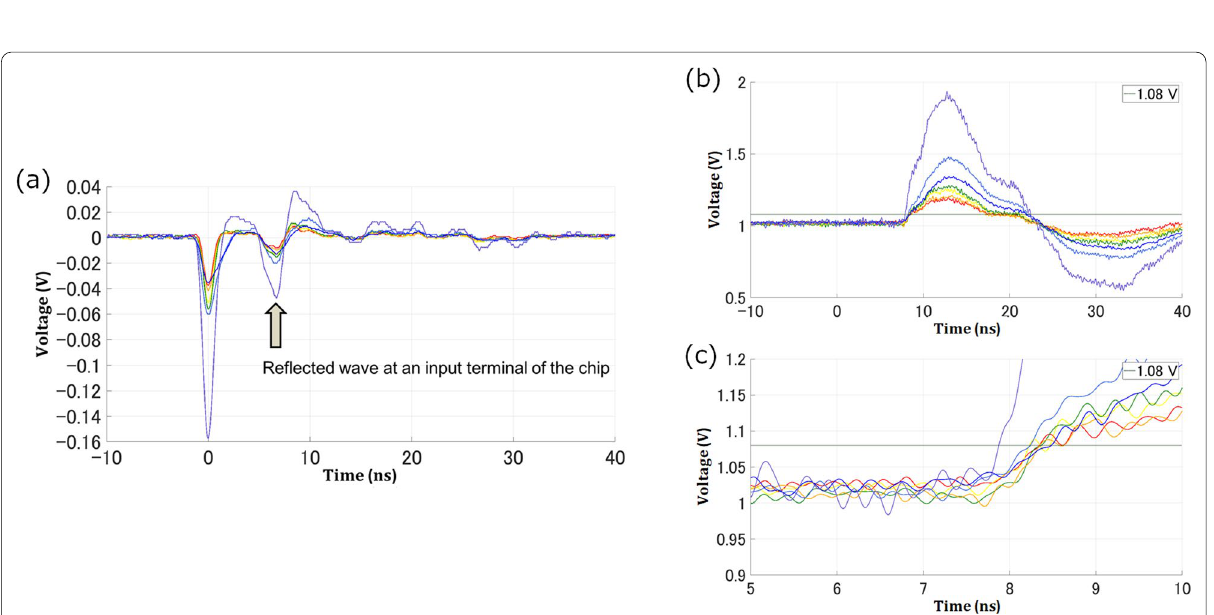
Fig. 7 Measured response of the current pulse amplification circuit. Waveforms were measured at the monitoring points (see Fig. 6). The time axis is defined so that the peak timing of the input waves is at 0 s. a Input pulse measured at CHIP IN, b output waveform measured at AMP. OUT, and c magnified view of panel b focusing on 5 - 10ns . Seven waveforms in panel a show examples of input pulse heights from 35mV to 200mV , which include the highest one (i.e., the purple line) among all the measured waveforms. Each waveform in panels b and c corresponds to the waveform of the same color in panel a . In panel a , the wave reflected at the input terminal of the chip appears; it does not appear in panel b because it is absorbed at the MCP side. The timing variation of the cross-points between the output rising waveforms and 1.08V is less than 1ns (see panel c